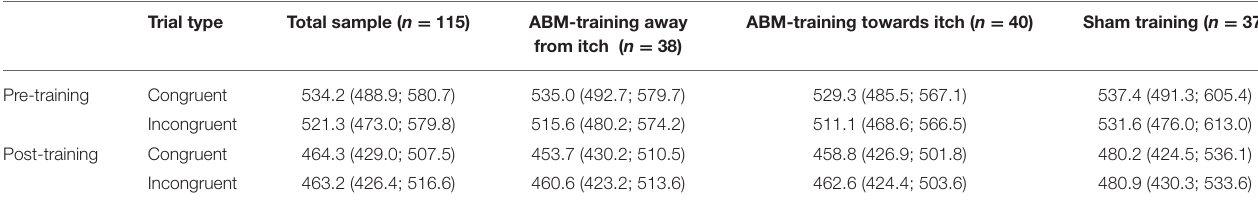
Table 3B | Median (and interquartile range; IQR) of reaction times for the trials congruent and incongruent to the itch pictures of the dot-probe tasks administered pre- and post-attention bias modification (ABM)-training, displayed for the total sample, and per training condition.